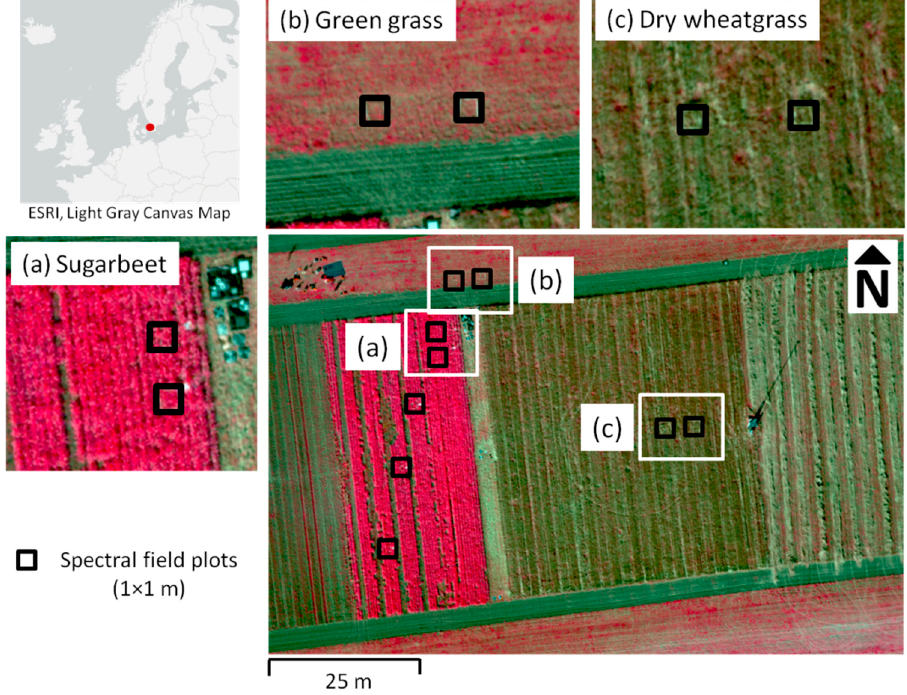
Figure 16. Color infrared reflectance map over the central part of the flight over Lönnstorp research station in south Sweden on 22 September 2020. The spectral field plots are marked with black squares with enlargements over two spectral field plots for green sugarbeet ( a ), green grass ( b ), and dry wheatgrass ( c ).